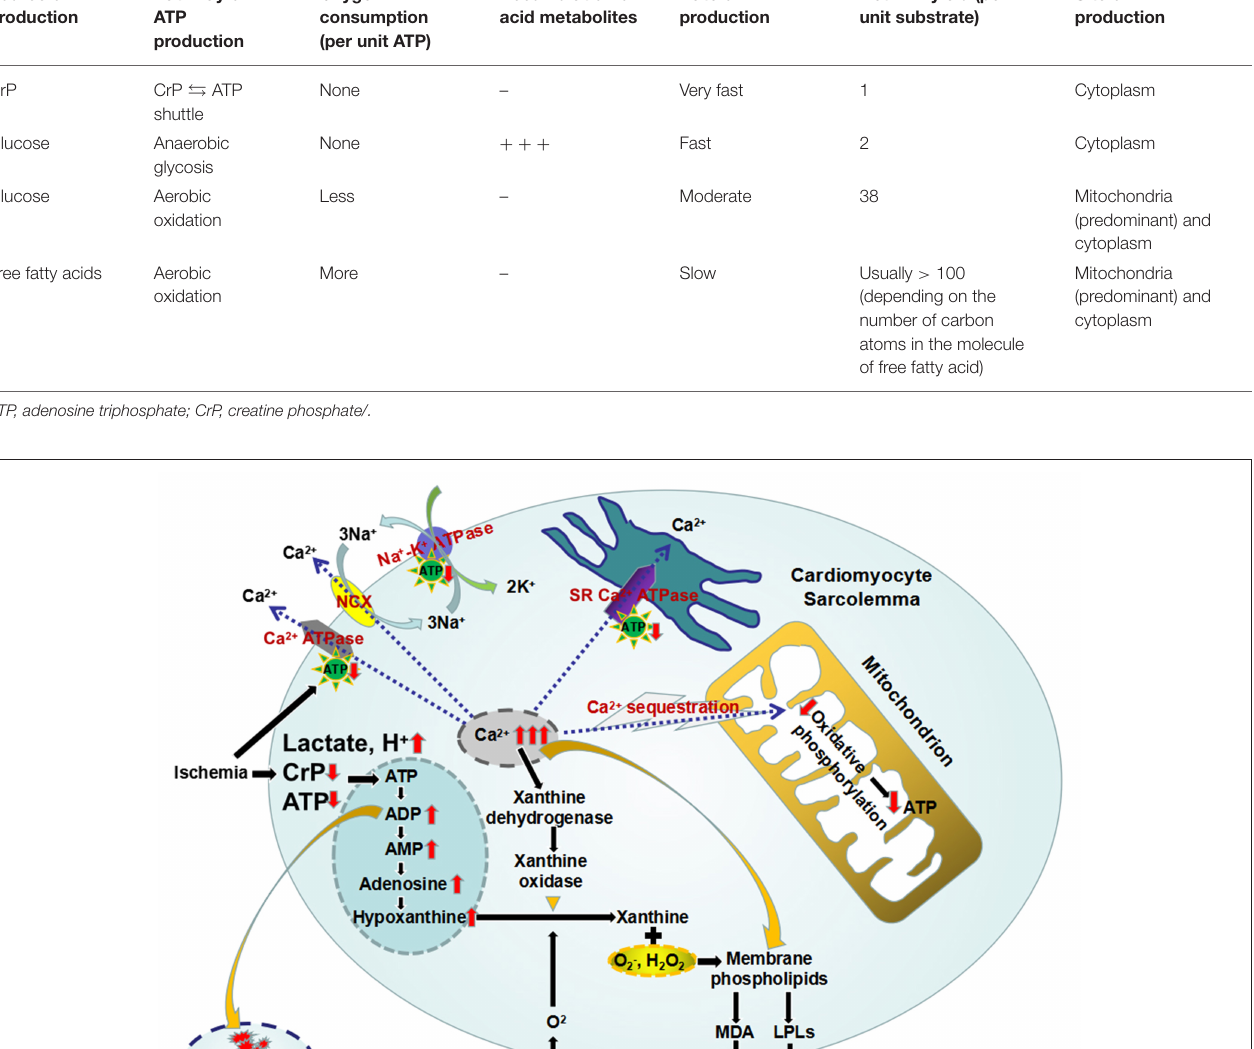
TABLE 1 | Myocardial energy metabolism: source, process and site of ATP production. Source of ATP